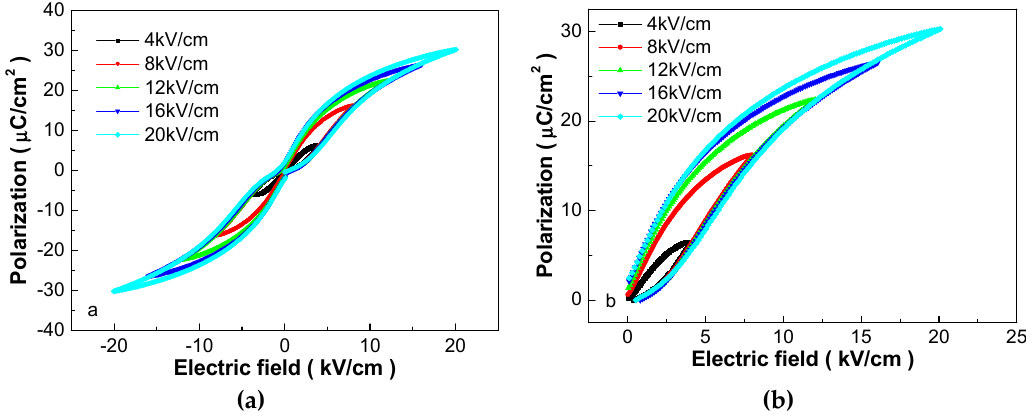
Figure 2. P-E hysteresis loops of the 0.25 mol% Y 2 O 3 -doped PSLZSnT ceramics measured at different electric fields. ( a ) bipolar; ( b ) unipolar.